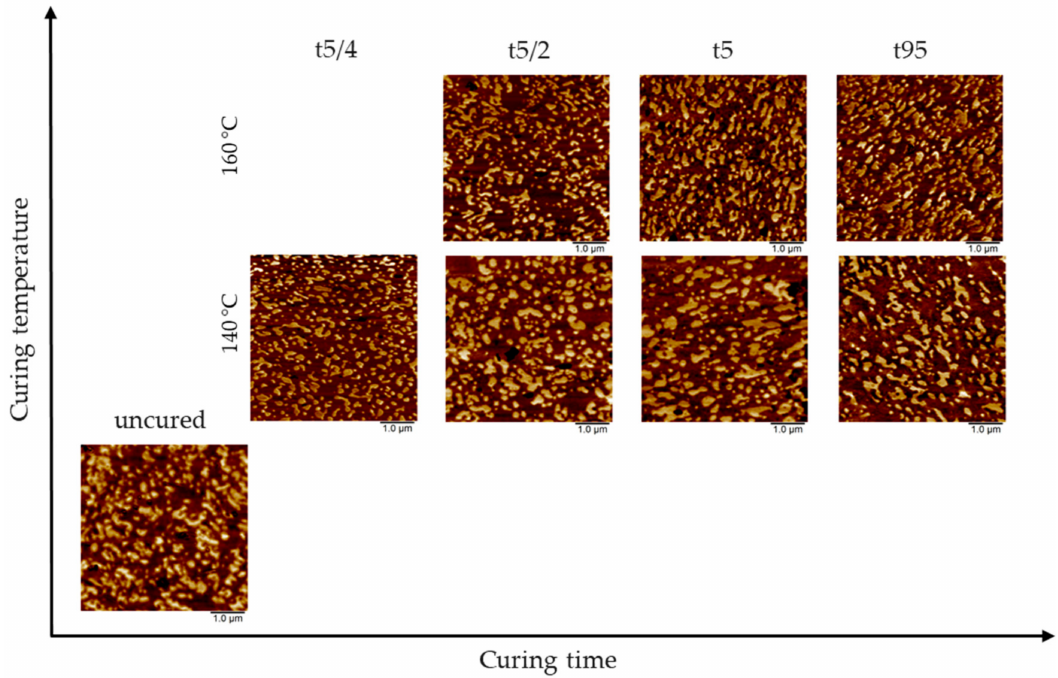
Figure 8. Comparison of adhesion maps regarding the influence of curing time and temperature on blend morphology in NR/SBR–HV blends. Curing times are defined according to Table